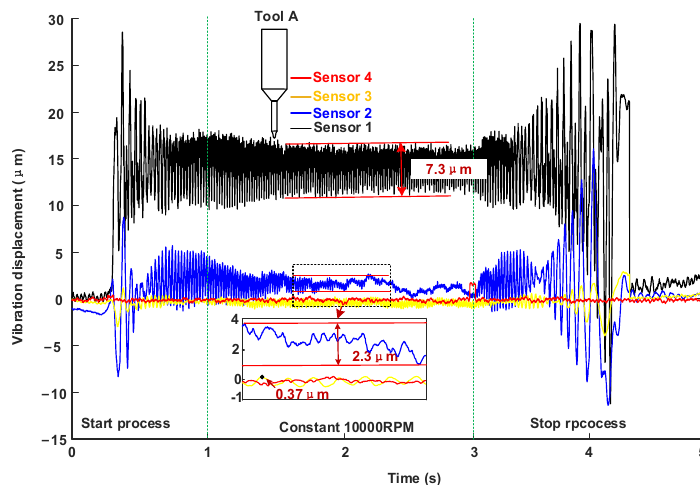
Figure 16. Cross-section area of Tool A and Tool B.